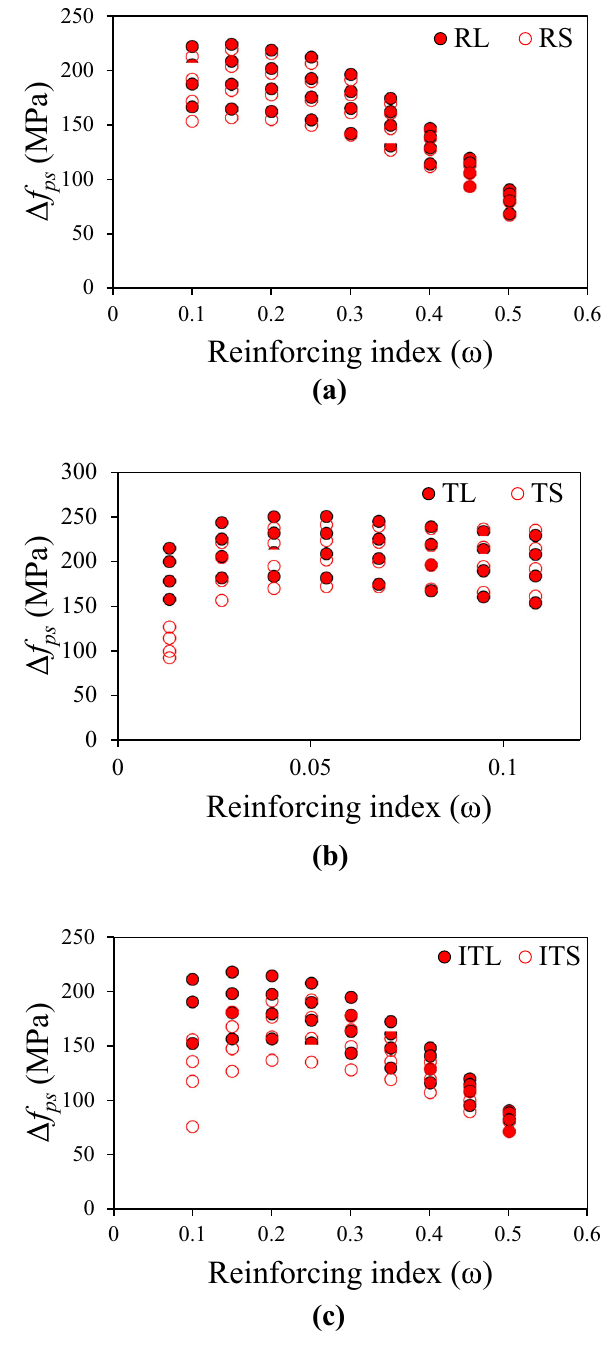
Fig. 12 Difference of D f ps according to the size of sec- tion, a Rectangular section, b Tee section, and c Inverted Tee section.